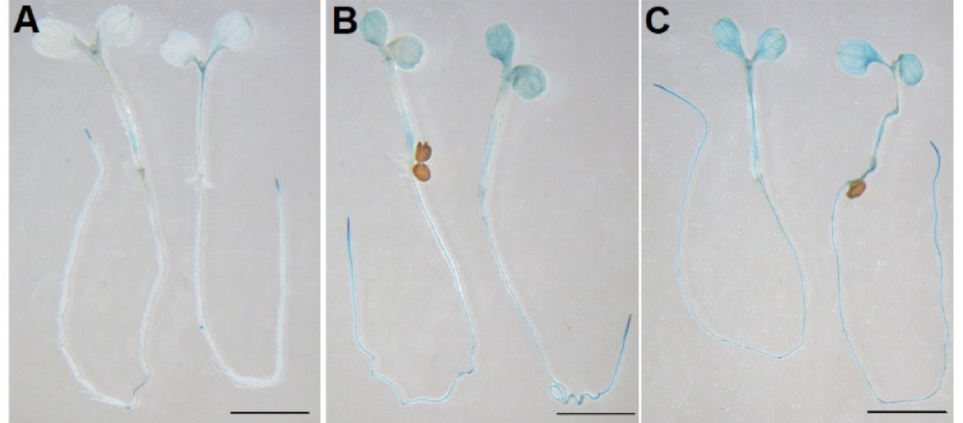
Figure 4. Comparison of GUS activity for ProPDI11::GUS transgenic plants under DTT or Tm treatment. Five-day-old seedlings of ProPDI11::GUS transgenic plants were treated with 2 mM DTT ( B ) or 5 µ g/mL Tm ( C ) for 5 h and then immersed fully into the GUS staining solution for 1 h in dark. Seedlings without treatment were used as control ( A ). Bar = 2